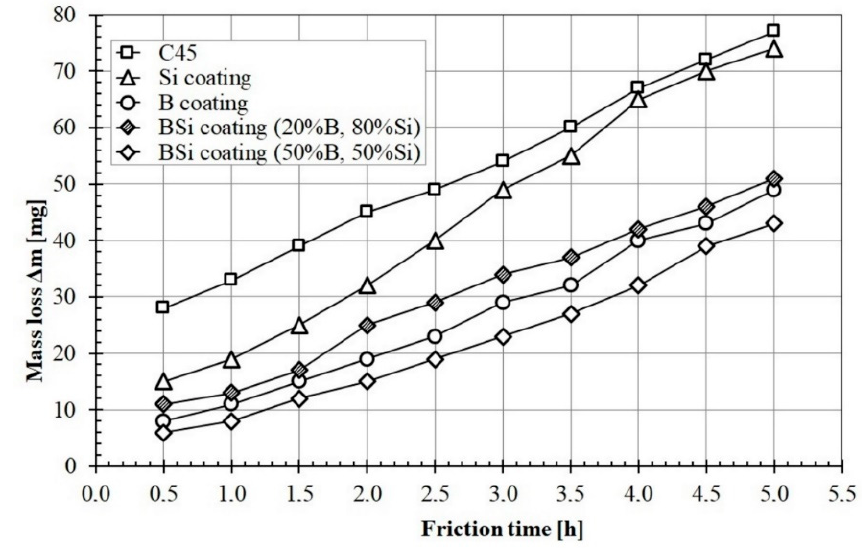
Figure 10. Wear resistance of studied B, Si and B-Si coatings.